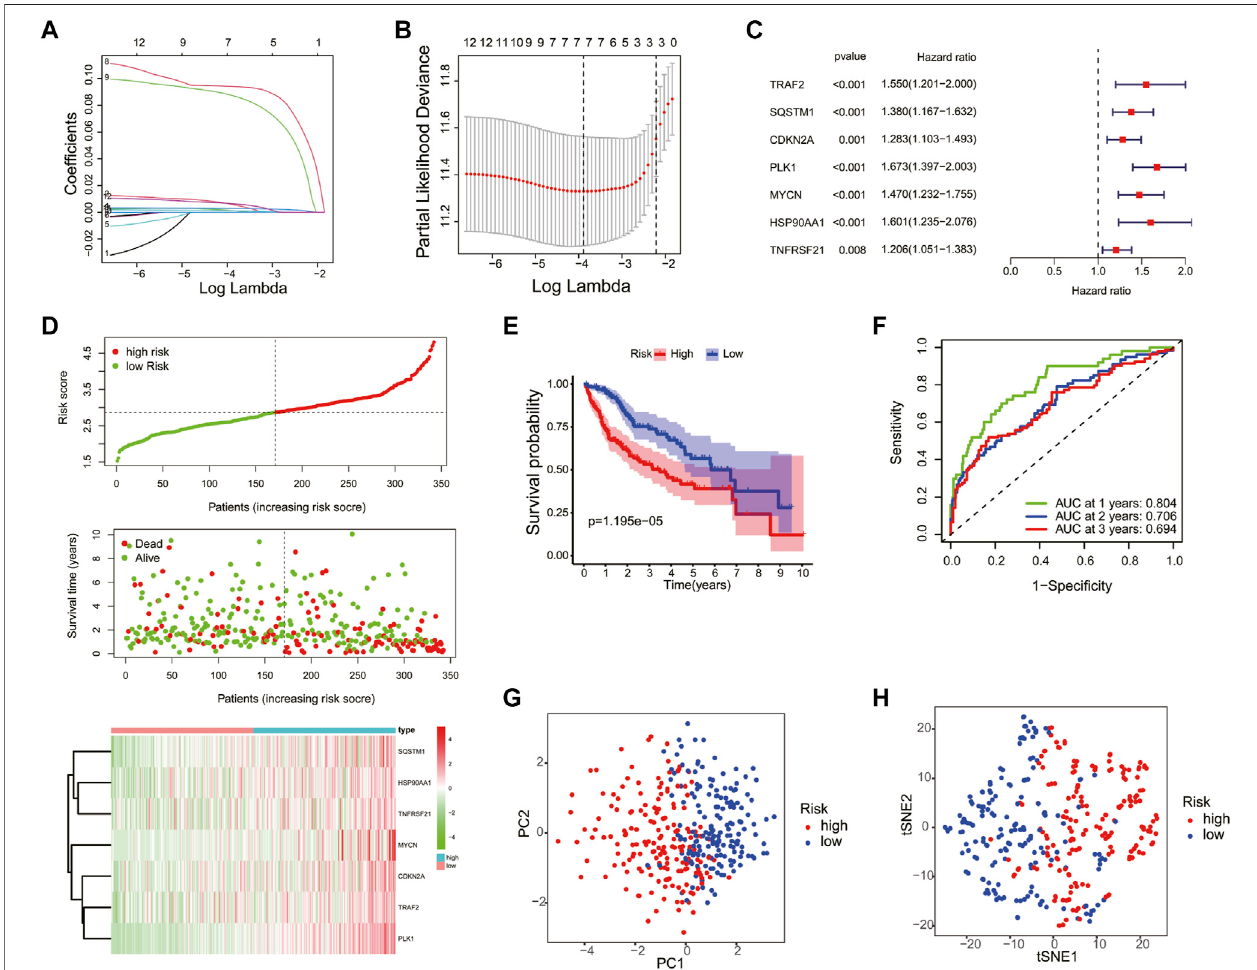
FIGURE 4 | Construction of the necroptosis gene-based prognostic model in the Cancer Genome Atlas (TCGA) training cohort. The association between log(lamba) and coef fi cients of genes (A) and deviance (B) . (C) Univariate Cox regression analysis was used to construct a prognostic model. (D) Distribution of the risk scores, survival status, and expression ofthe four necroptosis-related riskgenesin thetraining cohort. (E) The K – M curve ofthe low- and high-riskgroups based on the seven-necroptosis-related gene pro fi le. (F) Time-dependent ROC analysis for the 1-, 2-, and 3-year OS of the prognosis. PCA (G) and t-SNE (H) analysis of the TCGA cohort based on the risk